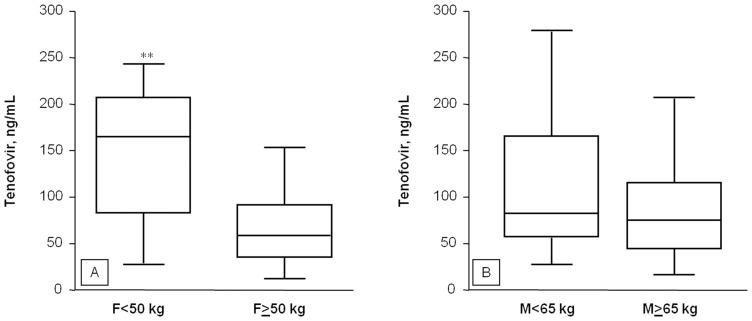
TDF plasma trough concentrations measured female (panel A) and male (panel B) HIV infected patients stratified according to median body weight (**p<0.01).